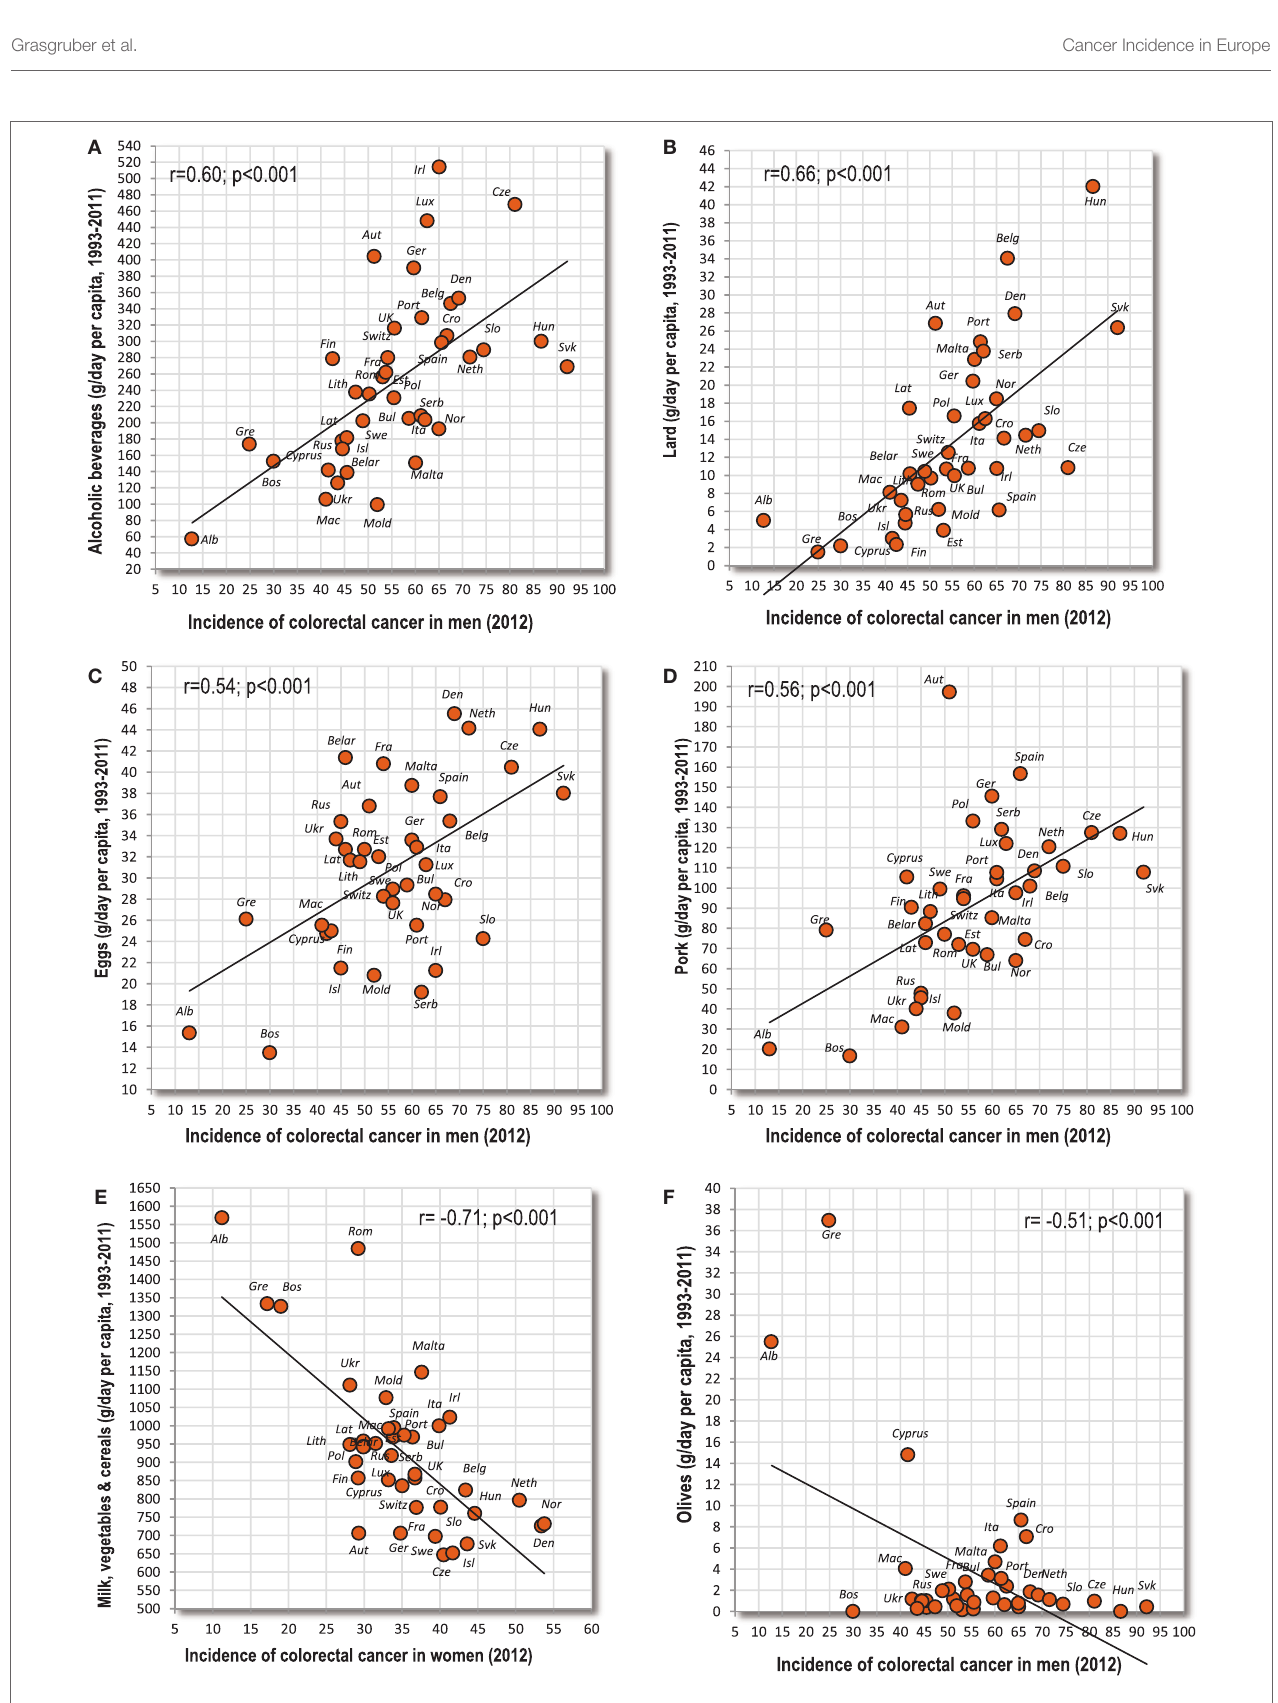
FigUre 2 | (a–F) Relationship between major independent variables and colorectal